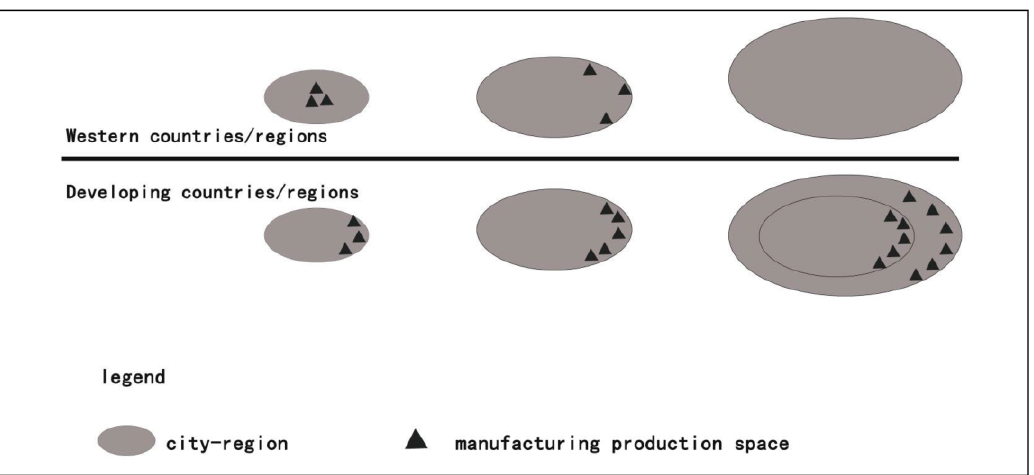
Figure 10. Comparison diagram of the evolution patterns of manufacturing production spaces in city regions between China and Western countries.